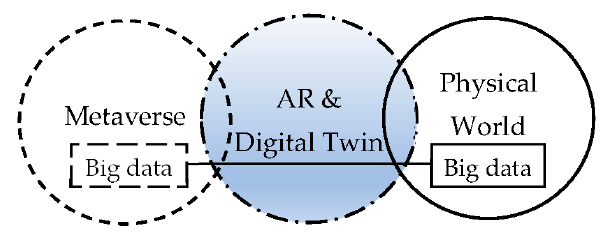
Figure 12. Big data plays a key component in both the physical world and virtual worlds. The Metaverse is a virtual world parallel to the real physical world: the two are sometimes connected by augmented reality and digital twin.